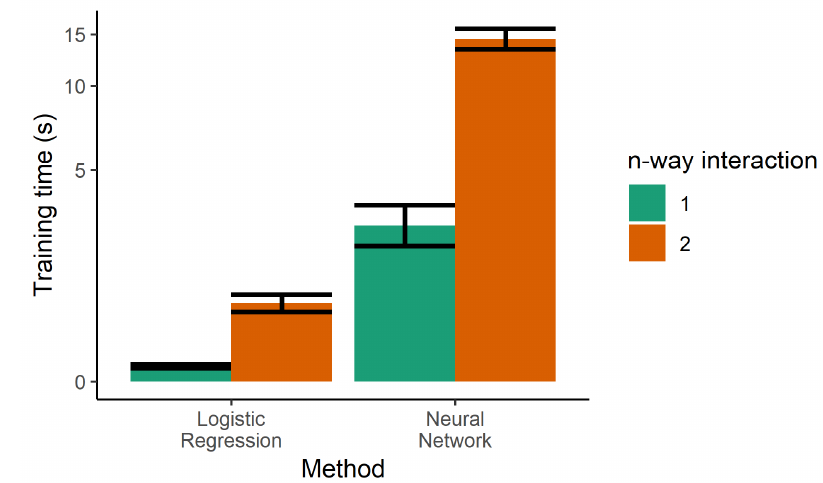
Figure 5. Training time for the single classifiers. Logistic regression was also trained with product terms (i.e., two-way interactions), dramatically increasing the training time. Due to the large dynamic range needed on the y -axis, it is drawn in the pseudolog transform.